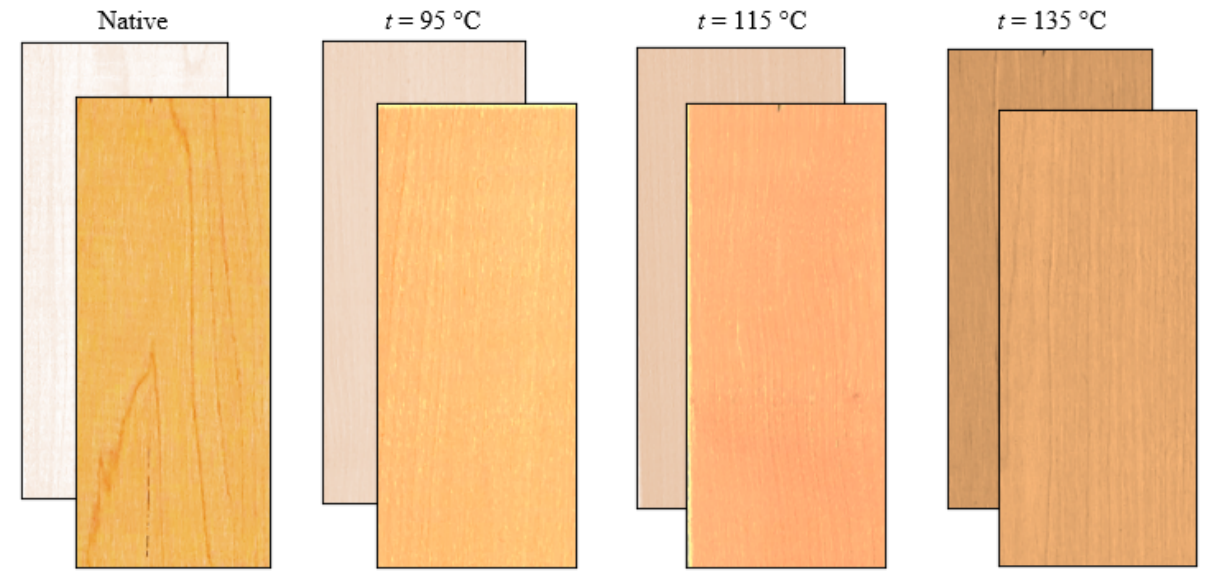
Figure 1. View of maple wood before and after UV irradiation: Native; steamed at t = 95 °C; steamed at t = 115 °C; steamed at t = 135 °C.